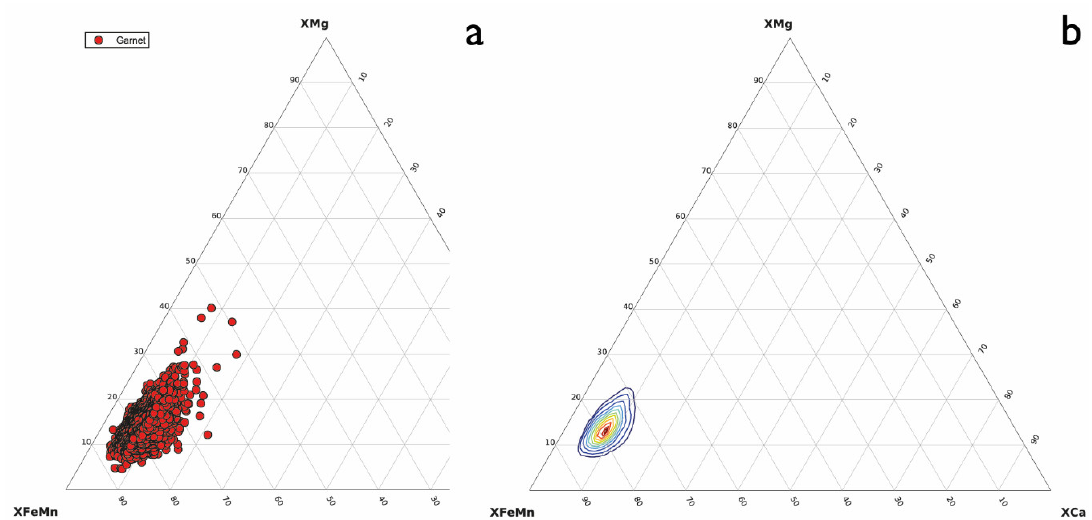
Figure 8. Ternary diagram showing the garnet porphyroblast minor element composition expressed as XMg–XFeMn–XCa. ( a ) Data for 6400 representative pixels; ( b ) Contours showing the data intensity of (a). The Figures are plotted applying WxTernary [42].